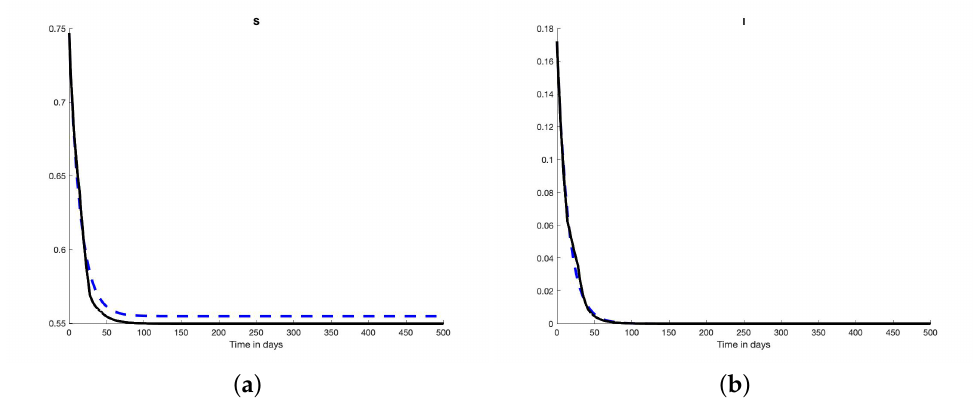
Figure 12. Scenario 5: States. ( a ) S and S ∗ (- -); ( b ) I and I ∗ (- -).